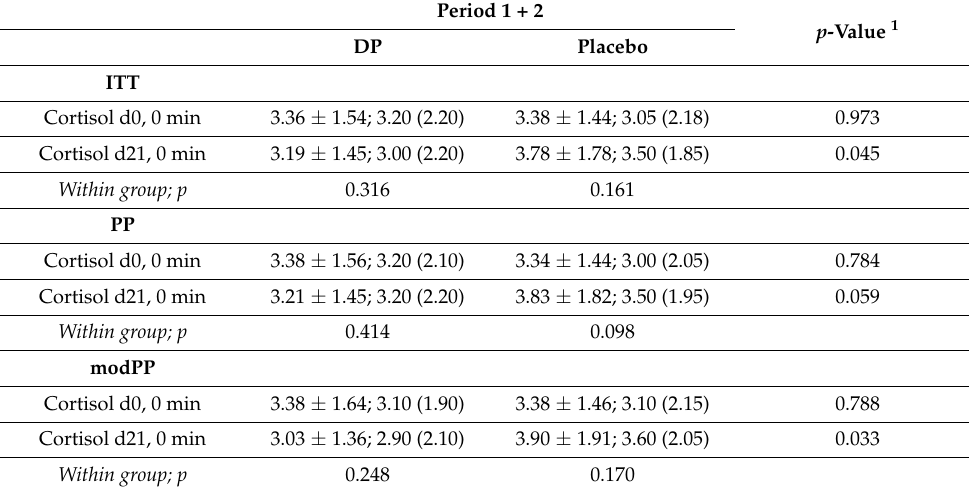
Table 5. Early morning saliva cortisol levels at baseline (day 0) and after 21 days of intervention (day 21) per treatment and in ITT, PP and modPP